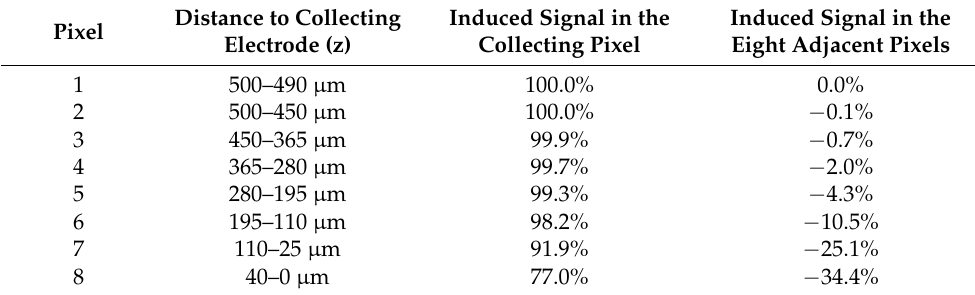
Table 2. Estimated drift length, induced signal in the collecting pixel and inducted signal in the eight neighboring pixels of the charge carriers generated in each pixel calculated using the Shockley- Ramo